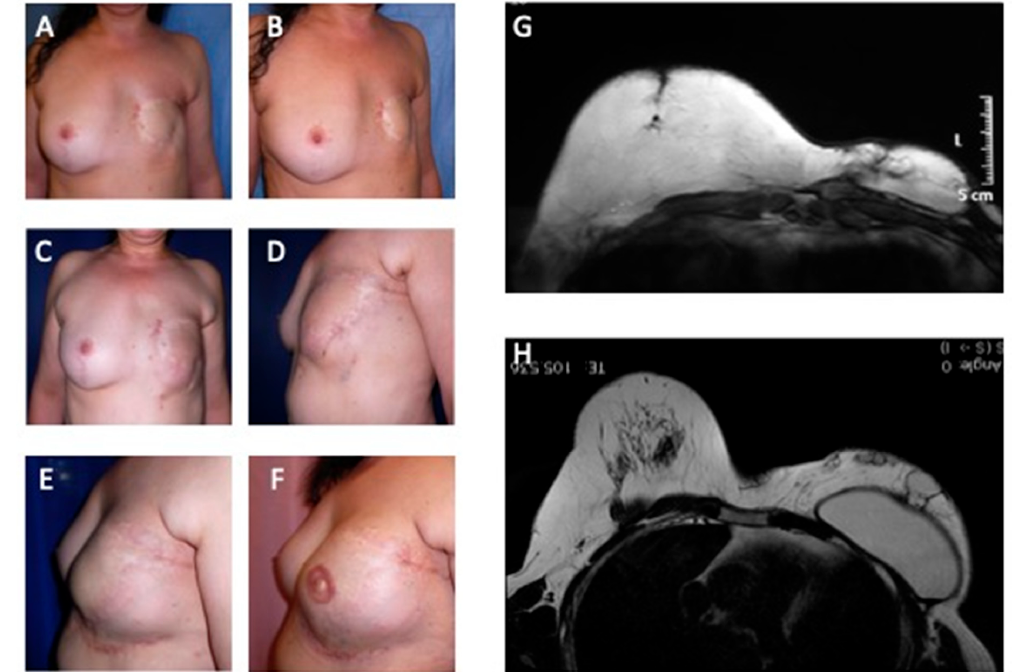
Figure 3. Analysis of study group’s patient a ff ected by outcomes of tram-flap failure. ( A ) Pre-operative in frontal view after outcomes of mastectomy in left breast; ( B ) Pre-operative in ¾ right view after outcomes of mastectomy in left breast; ( C ) Post-operative in frontal view after six months from 1st Engineered Fat Graft Enhanced with Adipose-derived Stromal Vascular Fraction cells (EF-e-A) injection in left breast; ( D ) Post-operative in ¾ left view after six months from 1st EF-e-A injection in left breast; ( E ) Post-operative in lateral left view after nine months from 2nd EF-e-A injection in left breast and implant of prostheses; ( F ) Post-operative in lateral left view after three months from nipple areola complex reconstruction; ( G ) Pre-operative MRI image of patient, before the prostheses implant and six months from 1st EF-e-A injection in left breast (condition referred at picture C,D); ( H ) Post-operative MRI image of patient, after the prostheses implant and nine months from 2nd EF-e-A injection in left breast (condition referred at picture